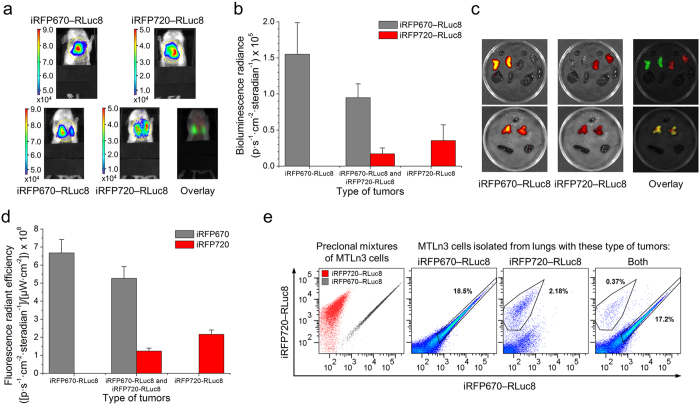
iRFP670—RLuc and iRFP720—RLuc tumor metastasis in mice.(a) BLI of metastasis in the lungs of mice with single (top row) or two different (bottom row) tumors (ventral view). The color bars indicate the total bioluminescence radiance (photons s−1 cm−2 steradian−1). The yellow circles represent regions of interest (ROI) used for data quantification. (b) Values of bioluminescence signals for the images in (a). (c) Ex vivo FLI of the internal organs of mice with one (top row) or two different (bottom row) tumors. (d) Values of fluorescence signal for the images in (c). (e) Representative FACS plots showing separation of MTLn3 preclonal mixtures stably expressing iRFP670—RLuc8 or iRFP720—RLuc8 and MTLn3 cells isolated from the lungs of mice. The gates were selected according to the brightness of MTLn3 preclonal mixtures. The numbers represent the relative average amount of cells in gates. Error bars, s.d. (n = 3).